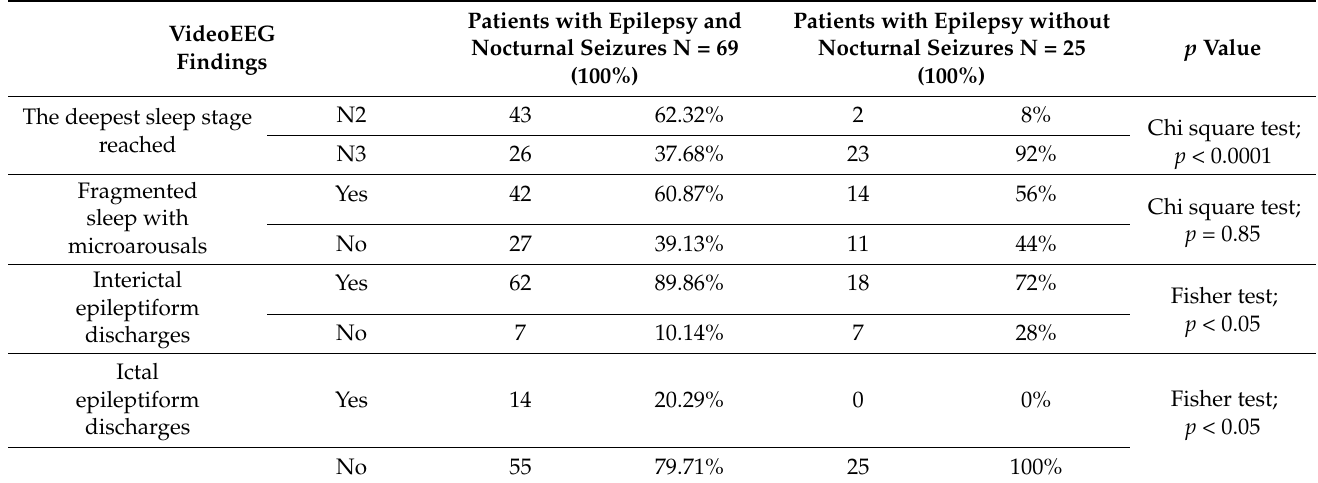
Table 5. Distribution of sleep stages and epileptiform discharges on video-EEG.